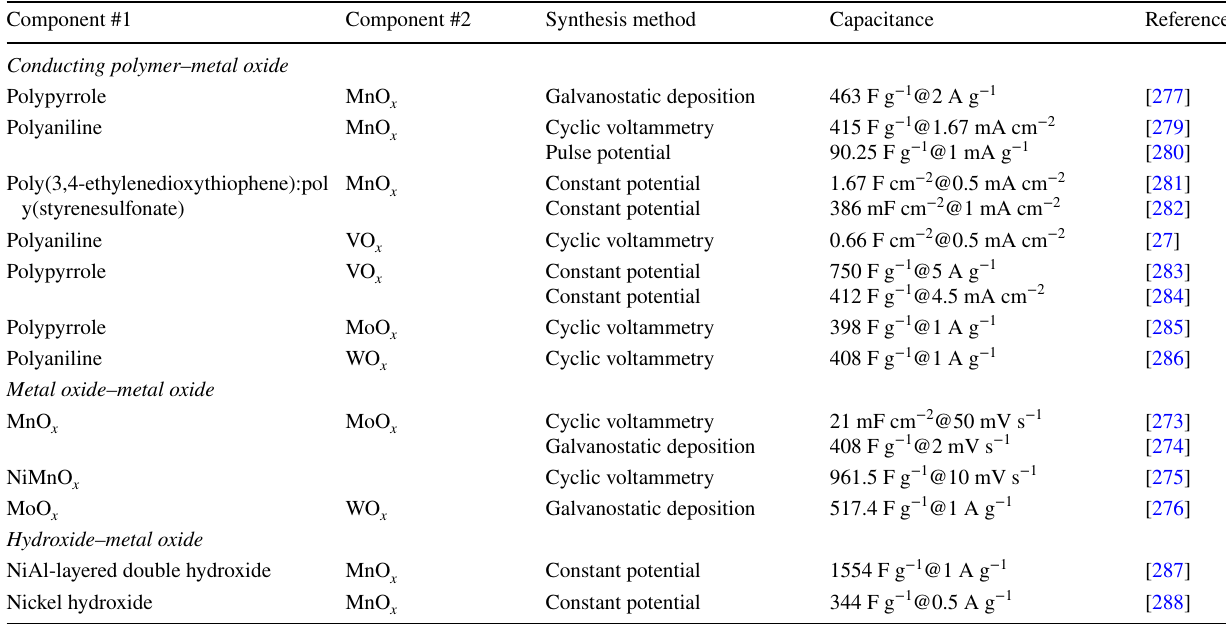
Table 2 Different types of composites synthesized via electrochemical methods Component